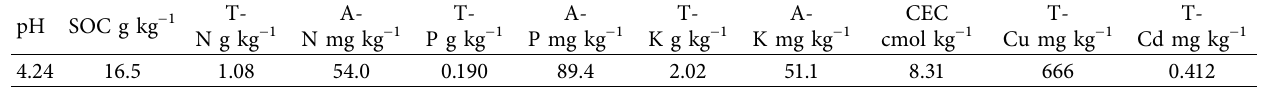
Table 1: Physicochemical properties of the tested